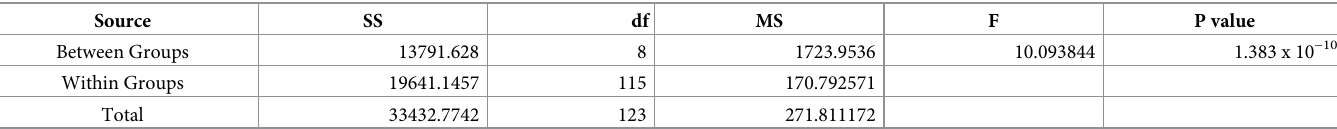
Table 2. ANOVA statistics of Z score test.